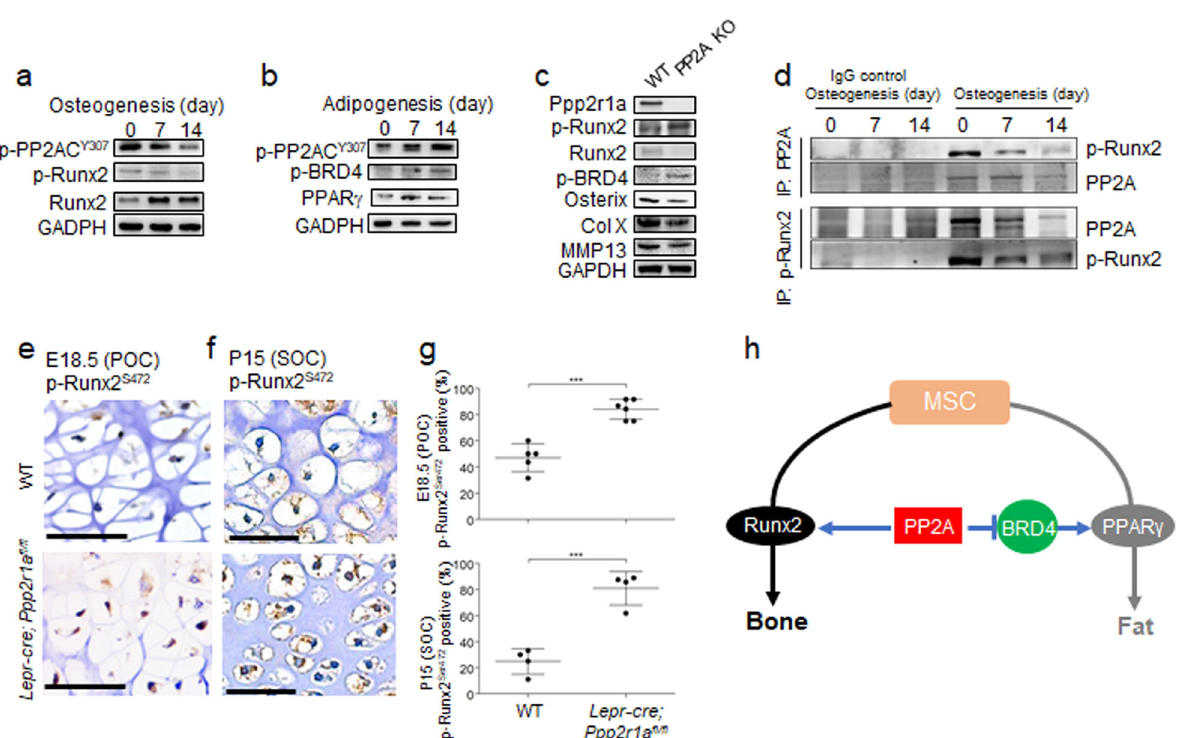
Fig. 7 PP2A deletion in LepR + MSCs increases Runx2 phosphorylation at Ser472 and reduces chondrocyte hypertrophy. MSCs isolated from WT (WT MSCs) and Lepr-cre; Ppp2r1a fl / fl mice (PP2A KO MSCs) were subjected to analysis. a Representative western blot analysis of WT MSCs after osteogenic induction. b Representative western blot analysis of WT MSCs after adipogenic induction. c Western blot analysis of WT and PP2A KO MSCs. d Co-Immunoprecipitation study of cell lysates from WT MSCs with indicated induction for osteogenesis. IP with PP2A-speci fi c or phospho Ser 472 Runx2-speci fi c antibody and precipitates were probed for phospho Ser472 Runx2 and PP2A. e and f IHC analysis of inactive form phospho Ser472 Runx2 expression in hypertrophic chondrocyte of POC (E18.5) and SOC (P15) from Lepr-cre; Ppp2r1a fl / fl mice and relative WT littermate mice. g Quanti fi cation of phospho Ser472 Runx2 percentage in hypertrophic chondrocyte of POC (E18.5) and SOC (P15) from Lepr-cre; Ppp2r1a fl / fl mice and relative WT littermate mice. *** p < 0.001 as determined with Student ’ s t -test. Data are mean ± s.d. h Scheme representing regulation of MSC differentiation by PP2A and its substrates protein. Scale bar, 50 μ bone formation through the processes of endochondral ossi fi cation. ossi fi cation, growth plate chondrocytes undergo apoptosis with deposition of bone matrix. Runx2, a transcription factor that promotes chondrocyte hypertrophy, which regulates transcription